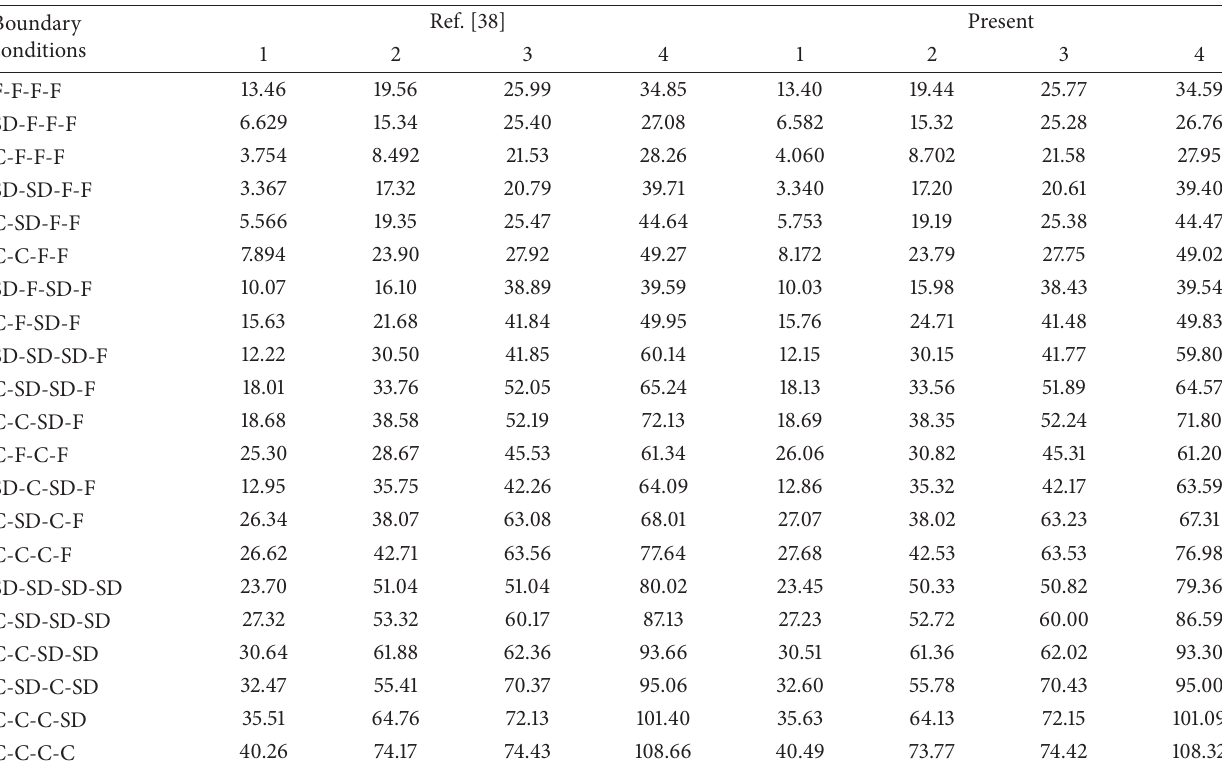
Table 11: Comparison of the first four frequency parameters Ω = 𝜔𝐿 2 √𝜌ℎ/𝐷 for an open spherical shell subjected to various boundary conditions.